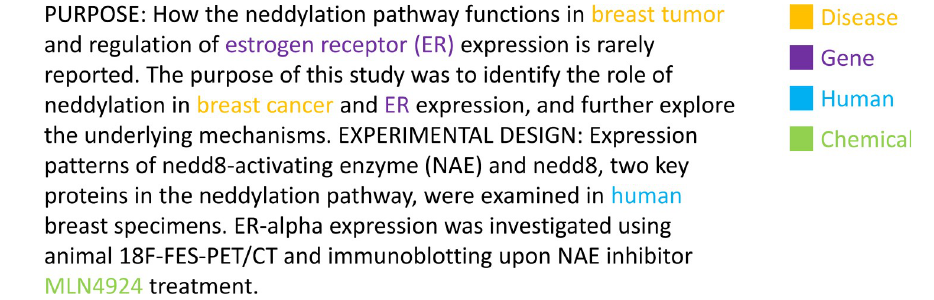
Fig 2. Identified bio-concept in-text and the normalized versions (one instance per type) in